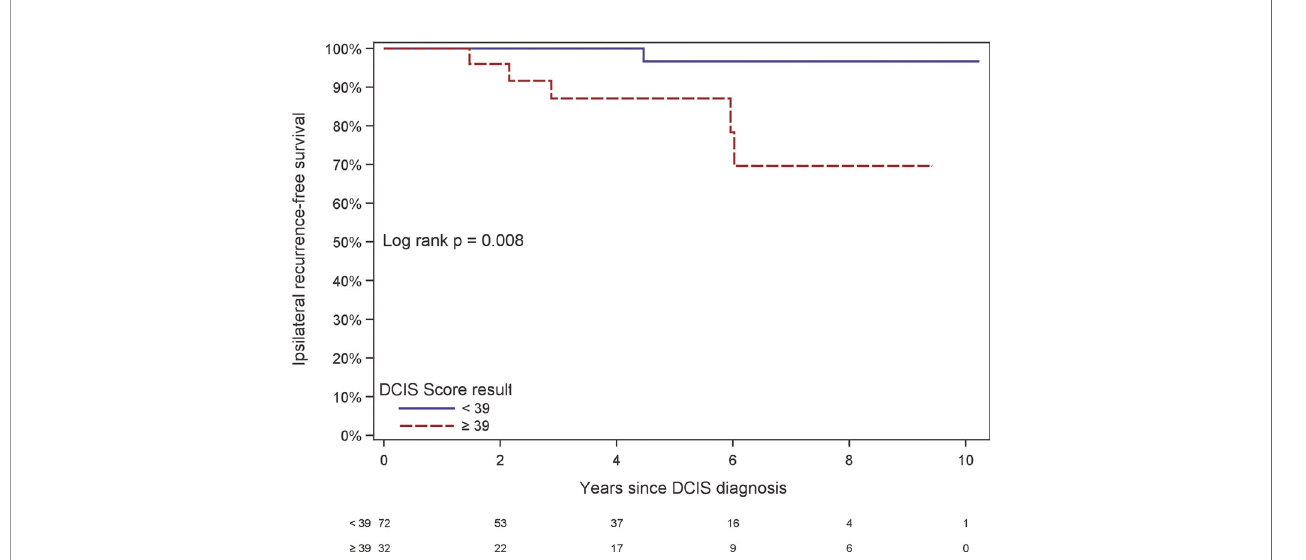
FIGURE 2 | Kaplan-Meier plot of ipsilateral recurrence-free survival by DCIS Score result. The table at the bottom of the fi gure shows the number at risk in even- numbered years since DCIS